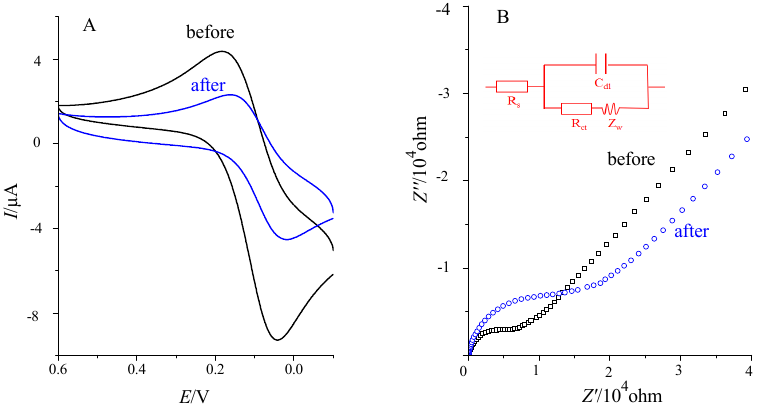
Figure 4. Characterization the immune response of biosensor by Cyclic Voltammetry ( A ) and AC impedance ( B ). The inset is the equivalent circuit applied to fit the impedance spectra.